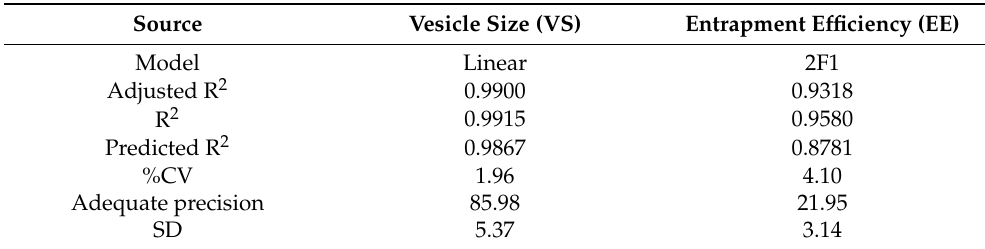
Table 2. Statistical summary of best fit model for vesicle size (R 1 ) and entrapment efficiency (R 2 ).